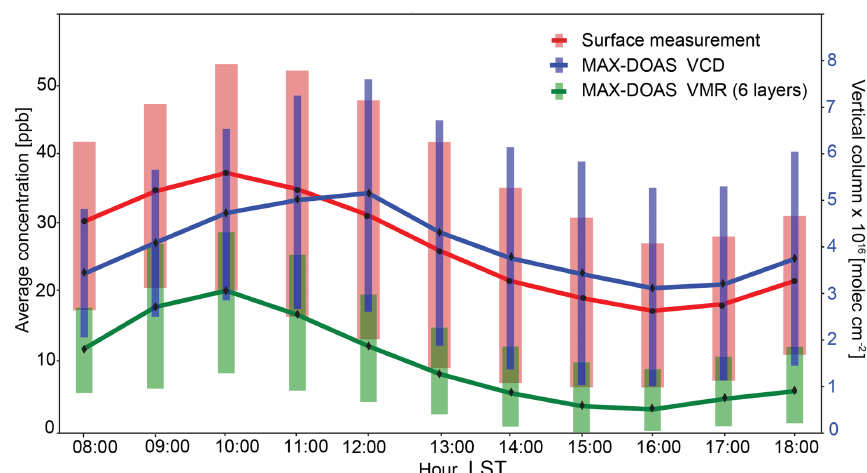
Figure 11. Diurnal NO 2 variability from hourly means of the entire data set spanning from January 2015 to July 2016. Only the data with coincident surface and MAX-DOAS measurements are included for consistency in the comparison. Vertical bars correspond to the standard deviations.